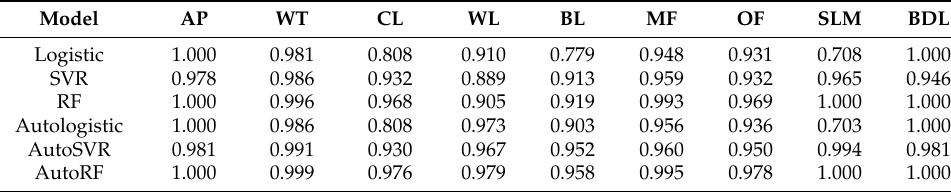
Table 2. AUC values of various land cover types in different